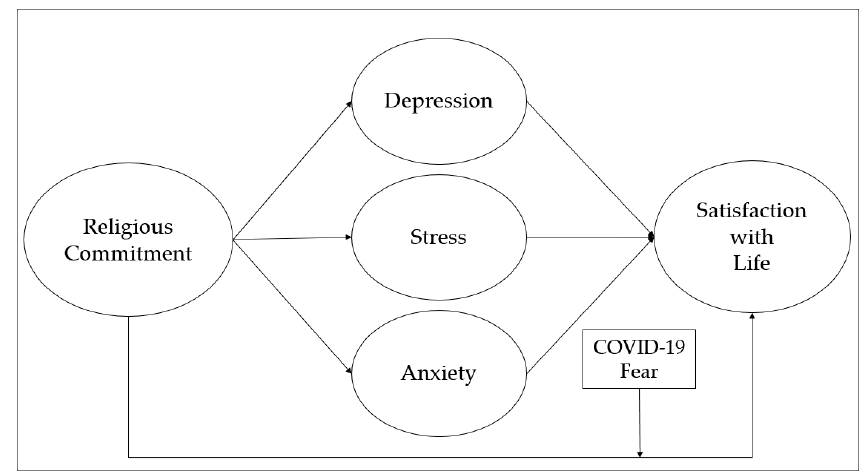
Figure 1. Conceptual framework of the study.